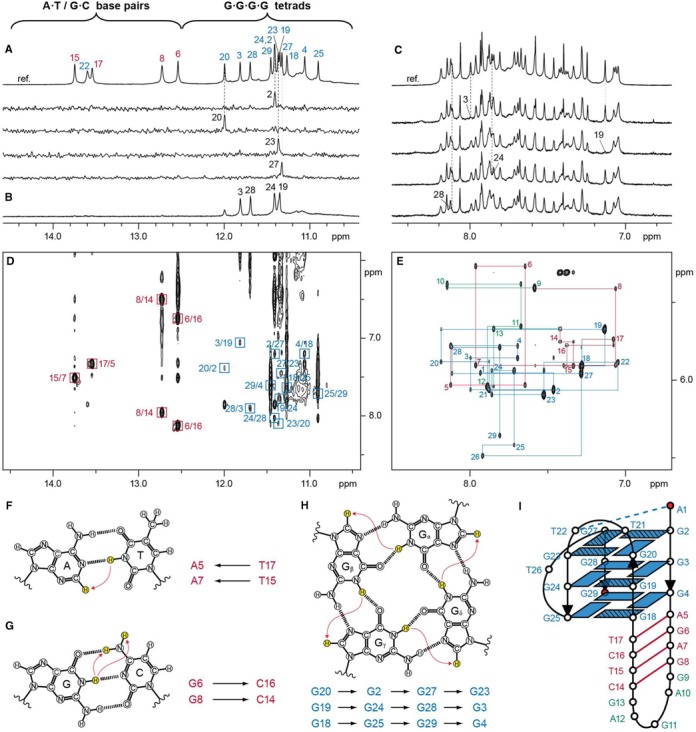
NMR structural characterization of the MYT1L gene sequence G4ST02001786748. (A) Assignments of G-tetrad imino protons through 15N-filtered spectra of samples, 2% 15N-labelled at the indicated positions. (B) 1D imino proton NMR spectrum after 2 h in D2O at 25°C. (C) Assignments of guanine H8 protons through site-specific 2H labelling at the indicated positions. (D) NOESY spectrum (mixing time, 200 ms) showing the cross-peaks that establish the alignment of the four Watson–Crick base pairs and the three G-tetrads. Cross-peaks between thymine imino proton and adenine H2 proton, and between guanine imino proton and cytosine amino protons, are framed in red and labelled with the residue number of thymine/guanine, followed by that of adenine/cytosine. Cross-peaks arising from imino-H8 connectivity around the three G-tetrads are framed in blue and labelled with the residue number of imino proton, followed by that of H8 proton. (E) NOESY spectrum (mixing time, 300 ms) showing the H8/H6-H1’ sequential connectivity of G4ST02001786748. Intraresidue H8/H6-H1’ NOE cross-peaks are labelled with residue numbers. (F) NOEs from thymine imino proton to adenine H2 proton that establish the A5•T17 and A7•T15 base pairs. (G) NOEs from guanine imino proton to cytosine amino protons that establish the G6•C16 and G8•C14 base pairs. (H) Cyclic guanine imino-H8 NOE connectivity patterns around a Gα•Gβ•Gγ•Gδ tetrad as indicated with arrows, with the connectivities observed for the G20•G2•G27•G23, G19•G24•G28•G3 and G18•G25•G29•G4 tetrads shown below. (I) Schematic diagram of the quadruplex–duplex hybrid structure adopted by G4ST02001786748. Quadruplex, duplex, and hairpin loop segments are coloured in blue, red and green, respectively. The 5′- and 3′-termini are shown as red circles. The non-canonical A1•T22 base pair is shown as a dotted line.